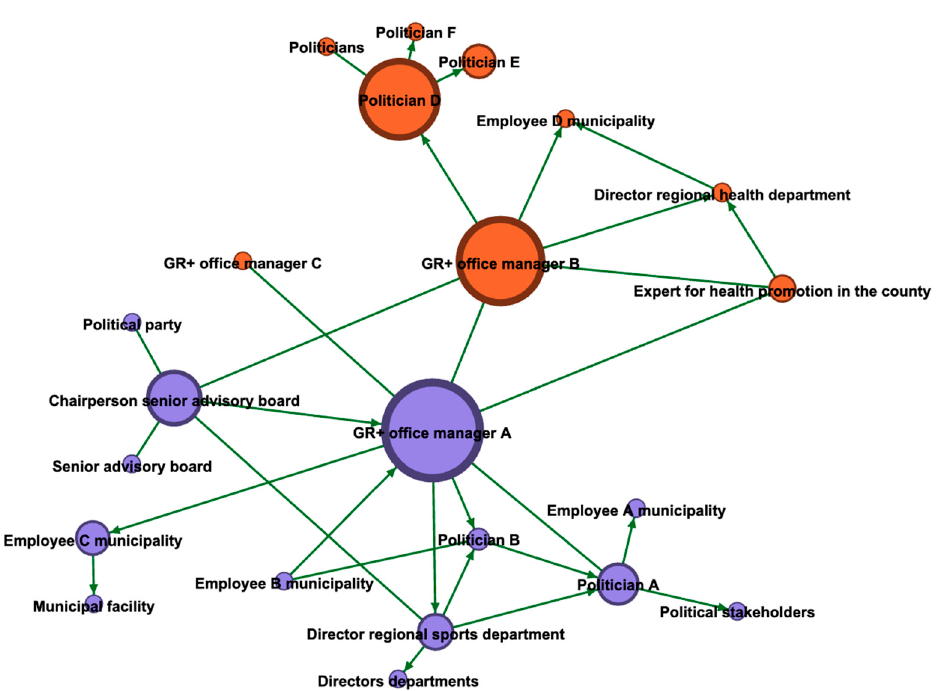
Figure 2. Map from the perspective of the project office managers split by actors from the city (purple nodes) and the county (orange nodes).